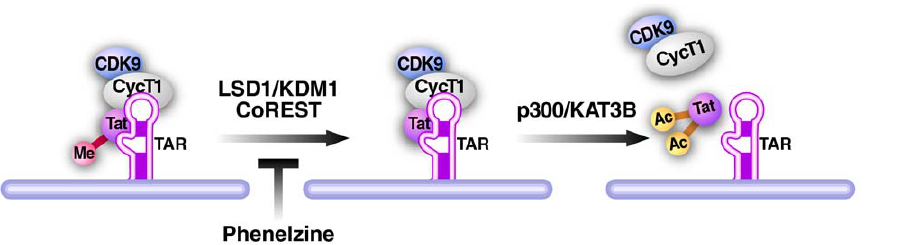
Figure 8. Model of LSD1/KDM1 action in HIV transcription. Demethylation of Tat by the LSD1/KDM1/CoREST complex is a required new step during Tat transactivation of the HIV LTR. We propose that it may occur before acetylation of Tat by p300/KAT3B. Inhibition of LSD1/KDM1 by phenelzine blocks this demethylation step and inhibits Tat transactivation during reactivation from latency.